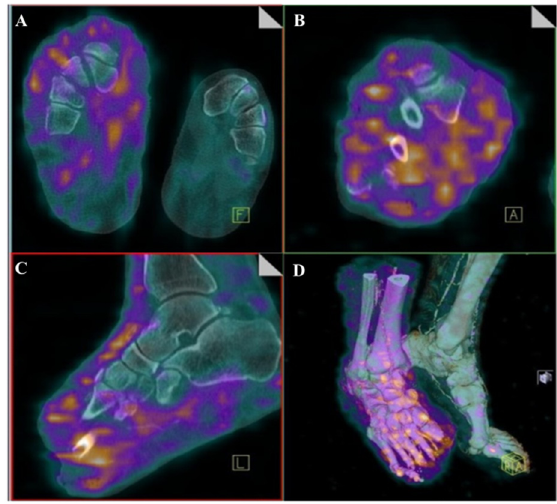
Figure 9. SPECT/CT of the feet of diabetic with a very advanced DFS. ( A ) Transverse cross-section of both feet. ( B ) Coronal cross-section of the right foot. ( C ) Sagittal cross-section of the right foot. ( D ) Three-dimensional reconstruction of both feet with visualization of bone tissues. Table 3. Evaluation of lipophilicity parameter of CIP-based radioconjugates containing 68 Ga radionuclide complex. [ 68 Ga]Ga-DOTA-CIP, Radioconjugate Lipophilic fragment Lipophilic fragment —– Bz-SCN-PA Bz-SCN-PA Elements of the radioconjugate Free carboxyl group of the Free two carboxyl groups of the —– molecule structure DOTA chelator DOTA chelator Negative charge Negative charge * 1 Neutral molecule *